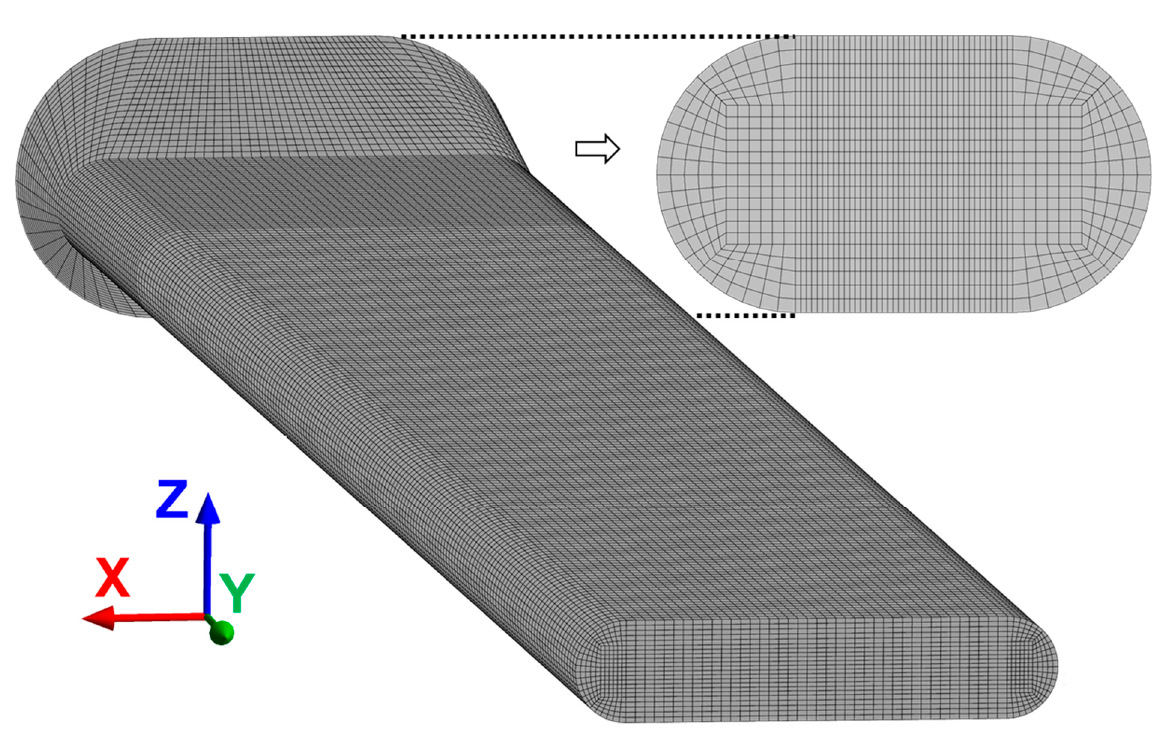
Figure A1. Hexahedral mesh with 69,520 elements used for the numerical simulations.